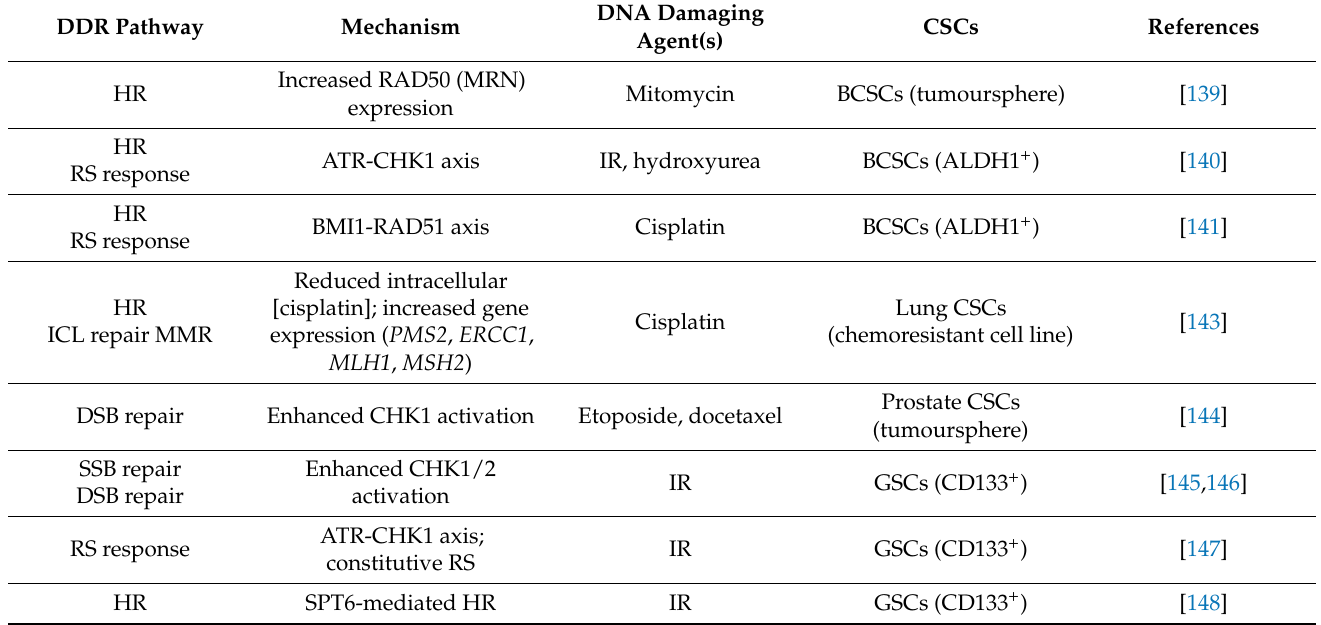
Table 2. Enhanced DNA repair efficiency in connection to CSC chemo/radioresistance